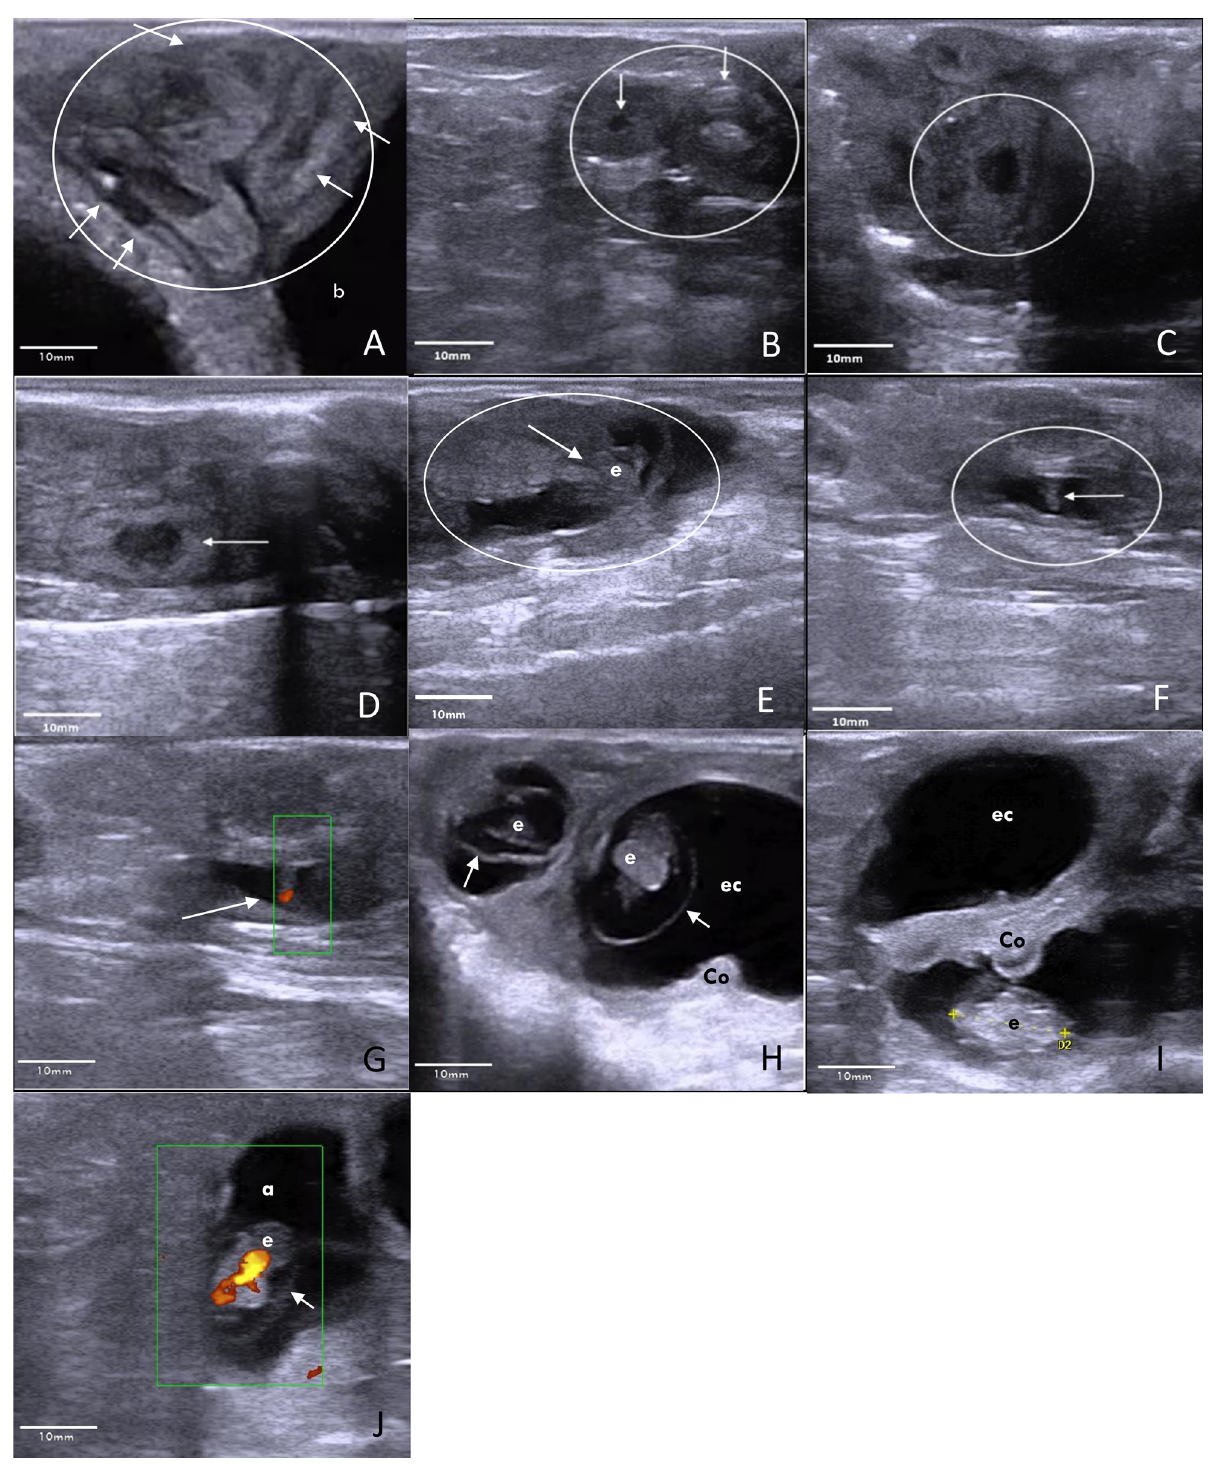
Fig 1. Transrectalultrasound (Esaote Germany, MyLab ™ One VET, equipped with electronic linear array 10–5 MHz transducer (SV3513Vet)) images of the ovary, uterus and developing conceptus during early pregnancy in sheep (oestrus = day 0). A Day 10: The coiled uterus (circle) is locatedcranial to the bladder(b). Within the coiled uterine horns, the lower echogenic endometrium (arrows) is well distinguished. B Day 10: Two corpora lutea (arrows) are present on the ovary (circle), documenting recent ovulation. C Day 12: Trophoblastic expansion(within the circle): At the site of trophoblasticexpansionthe endometriumappearedenlarged.A dark oval shaped structure expandedwithin the uterine lumen. Boundaries betweenendometrium and trophoblast could not be distinguished at this stage. Yet the trophoblast expandedthe uterine lumen exceedingthe regularendometrial heightby 2-fold. D Day 14: Trophoblastic expansion